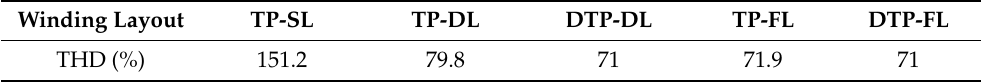
Table 1. THD of multi-phase and multi-layer winding